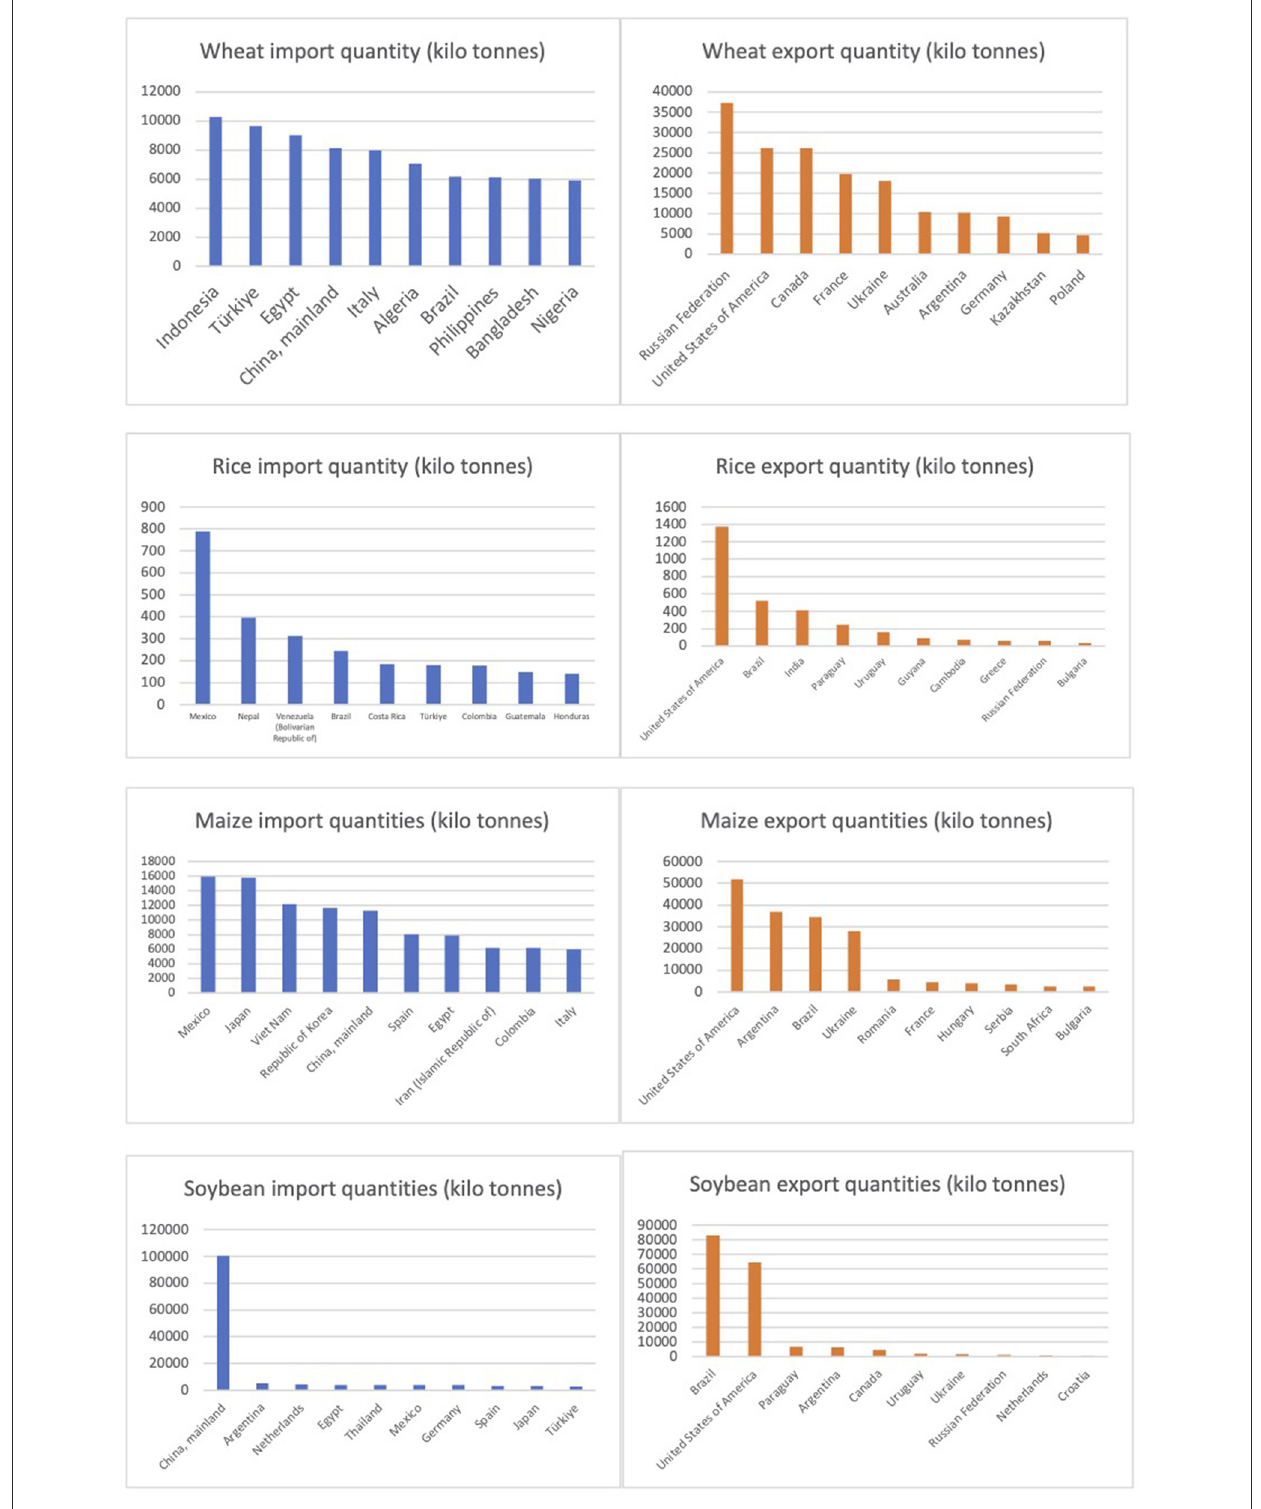
FIGURE5 Import and export quantities (kilo tons) for the four major staple crops (wheat, rice, maize, and soybean) (FAOSTAT, 2022).